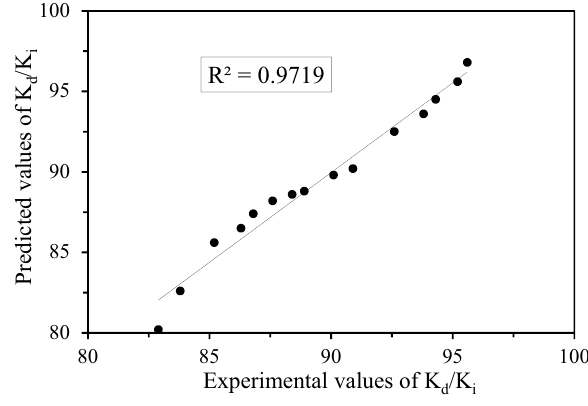
Fig. 5 Comparison of predicted and experimental data on formation damage during the LSWI process in the absence of scale inhibitor and